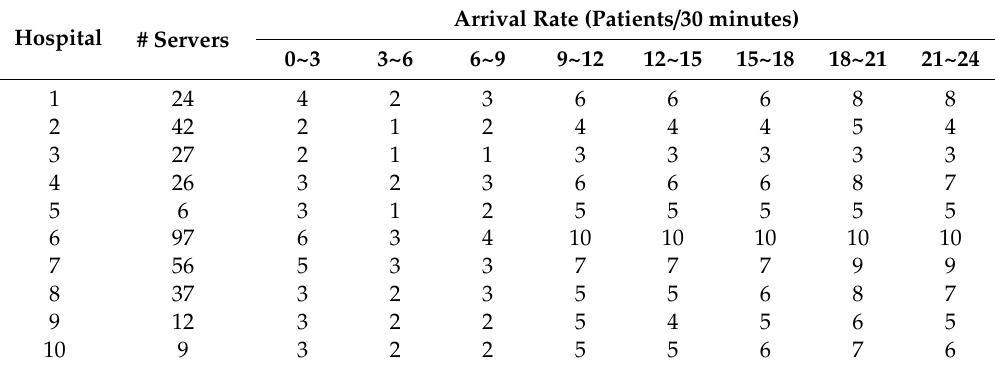
Table A1. Number of servers and demands of